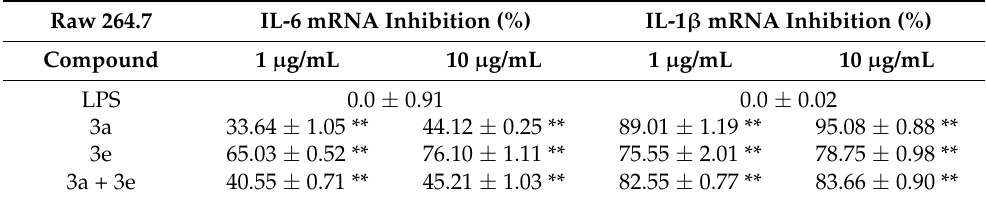
Table 2. The inhibitory effects of 2,5-diaminobenzoxazole derivatives on IL- 6 and IL-1β mRNA from macrophages.